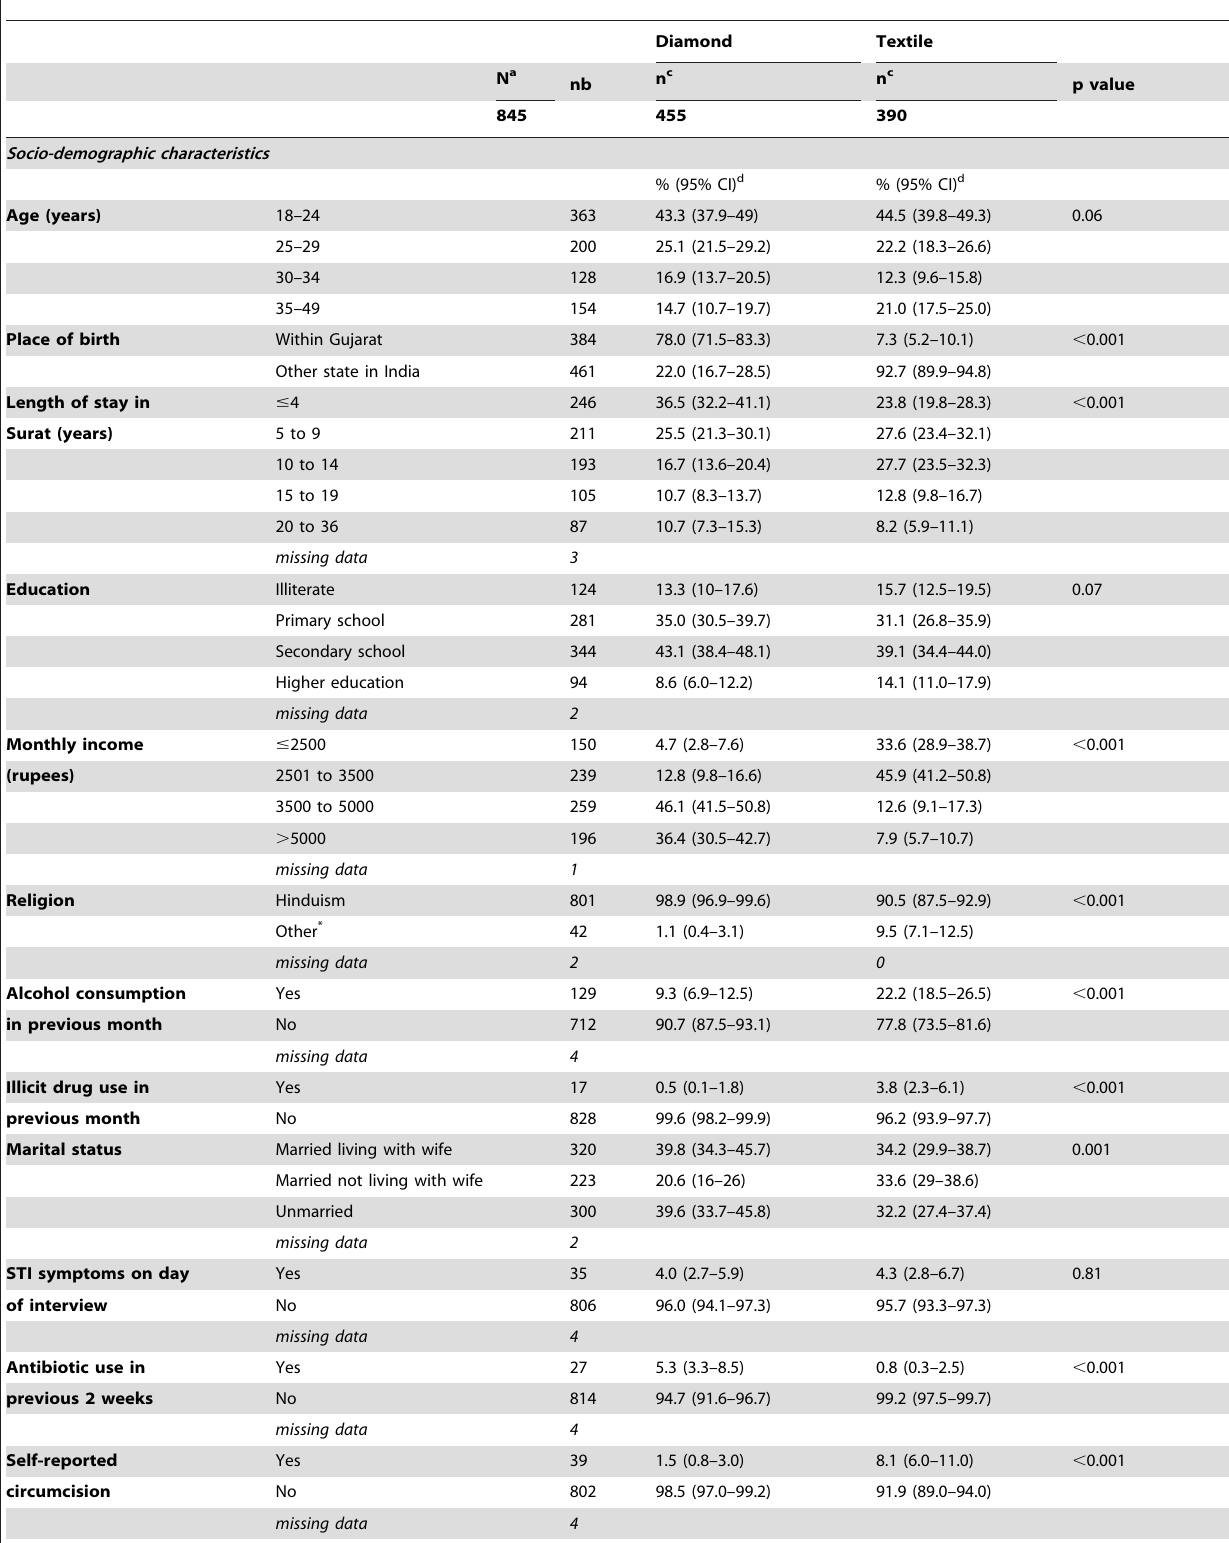
Sexualbehaviour